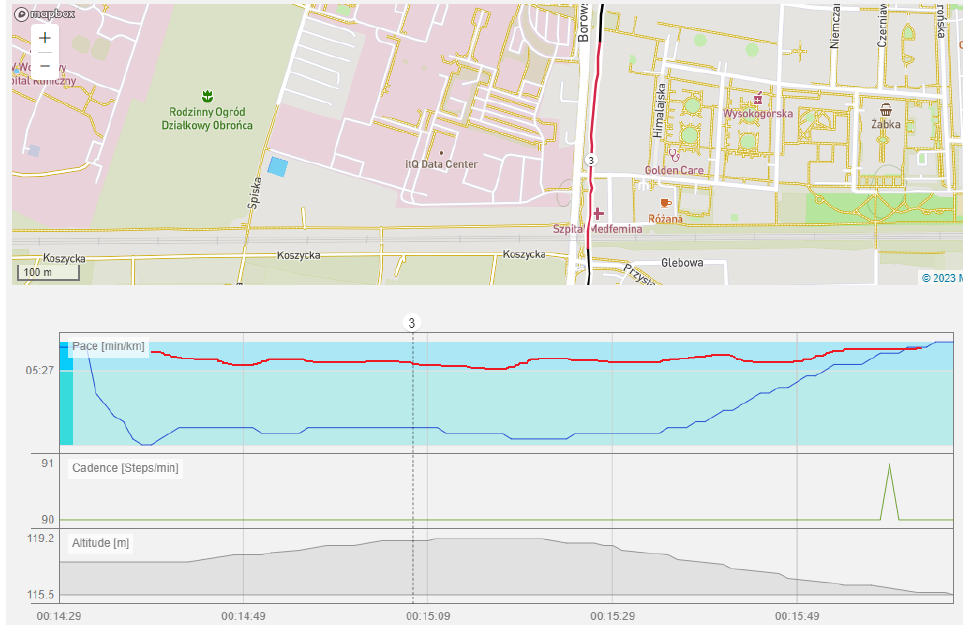
Figure 12. Running through the tunnel. Blue—speed without post processing, red—speed with proposed system, green—cadence (steps/min). (PolarFlow application